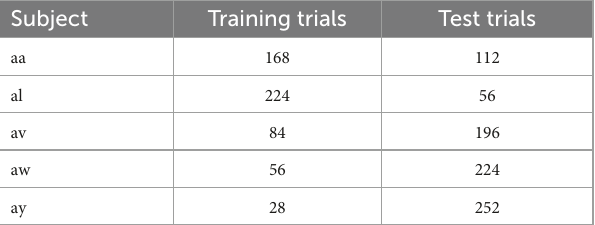
TABLE 1 The number of training and test trials for each subject of the dataset